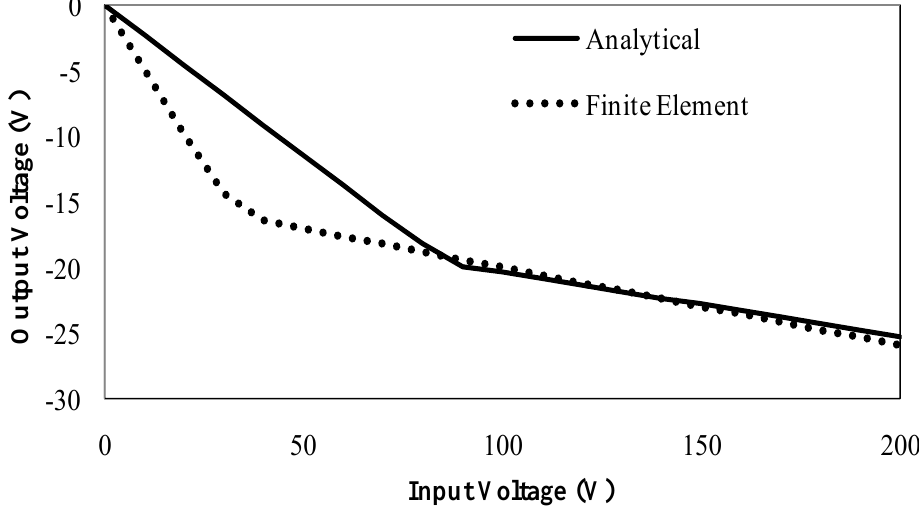
Figure 7. Comparison of the results for analytical and finite element solution with larger piezoelectric members when plasticity is